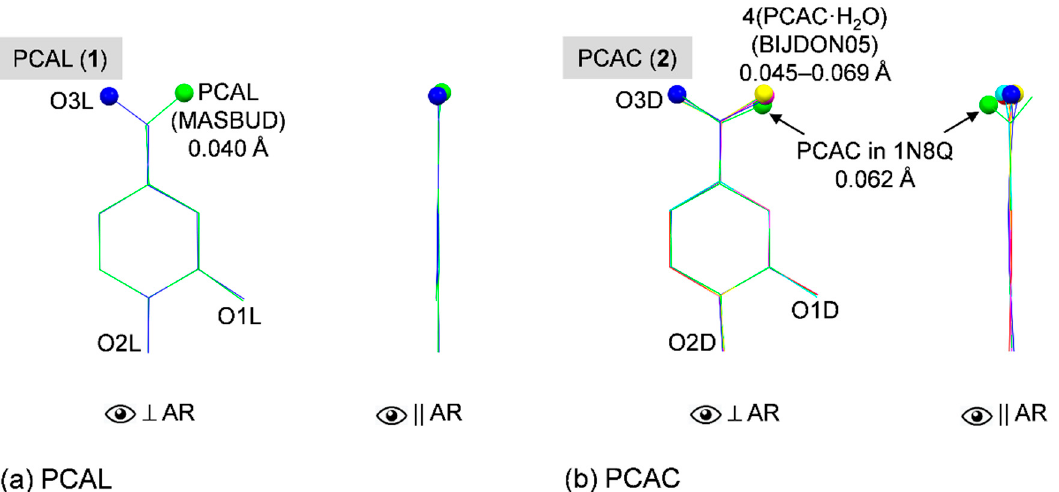
Figure 8. Structure overlays of ( a ) PCAL and ( b ) PCAC in uncomplexed form, in β -CD cavity and in complex with protein (if available), viewed perpendicular and parallel to the aromatic ring (AR). Reference structures are shown in blue wireframes of which their names are marked in gray areas and only non-H atoms of the rigid parts of polyphenols (excluding O3 and O4) are used for calculating the rms fits. The corresponding rms fit for each structure pair is indicated by nearby distance. Note that the orientation of C7=O3 group with respect to O1 is emphasized by ball model.